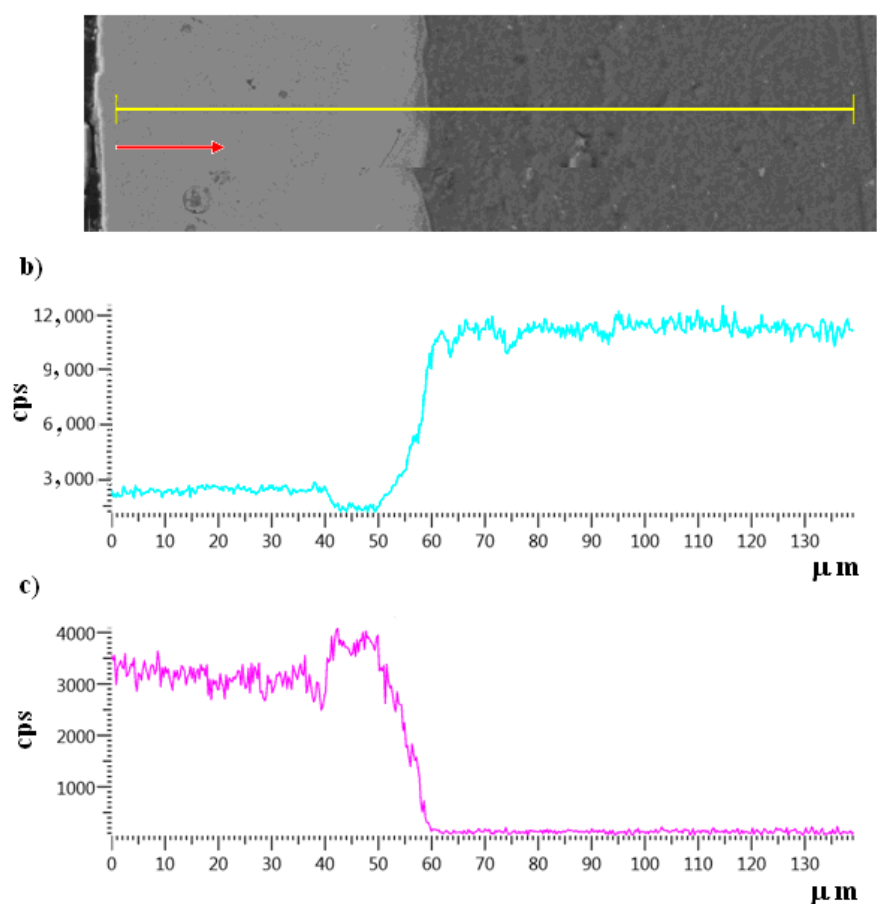
Figure 4. Scanning electron microscopy (SEM) micrograph and energy-dispersive spectroscopy (EDS) for Al/Cu alloy and the results of point X-ray microanalysis of the chemical composition of the tested alloy.